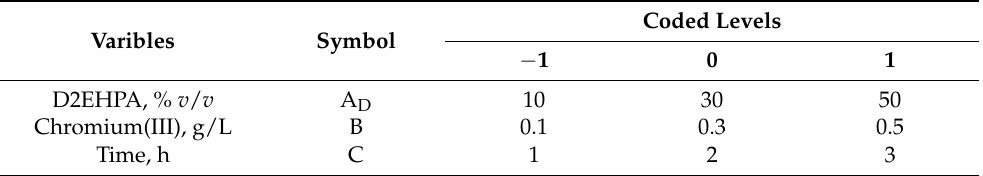
Table 1. Level and code of variables for Box–Behnken design for DCSLM with threshold concentration of D2EHPA. Varibles Symbol Cyanex272, % v / v Chromium(III), g/L Time, h Table 2. Level and code of variables for Box–Behnken design for DCSLM with threshold concentration of Cyanex272. Varibles